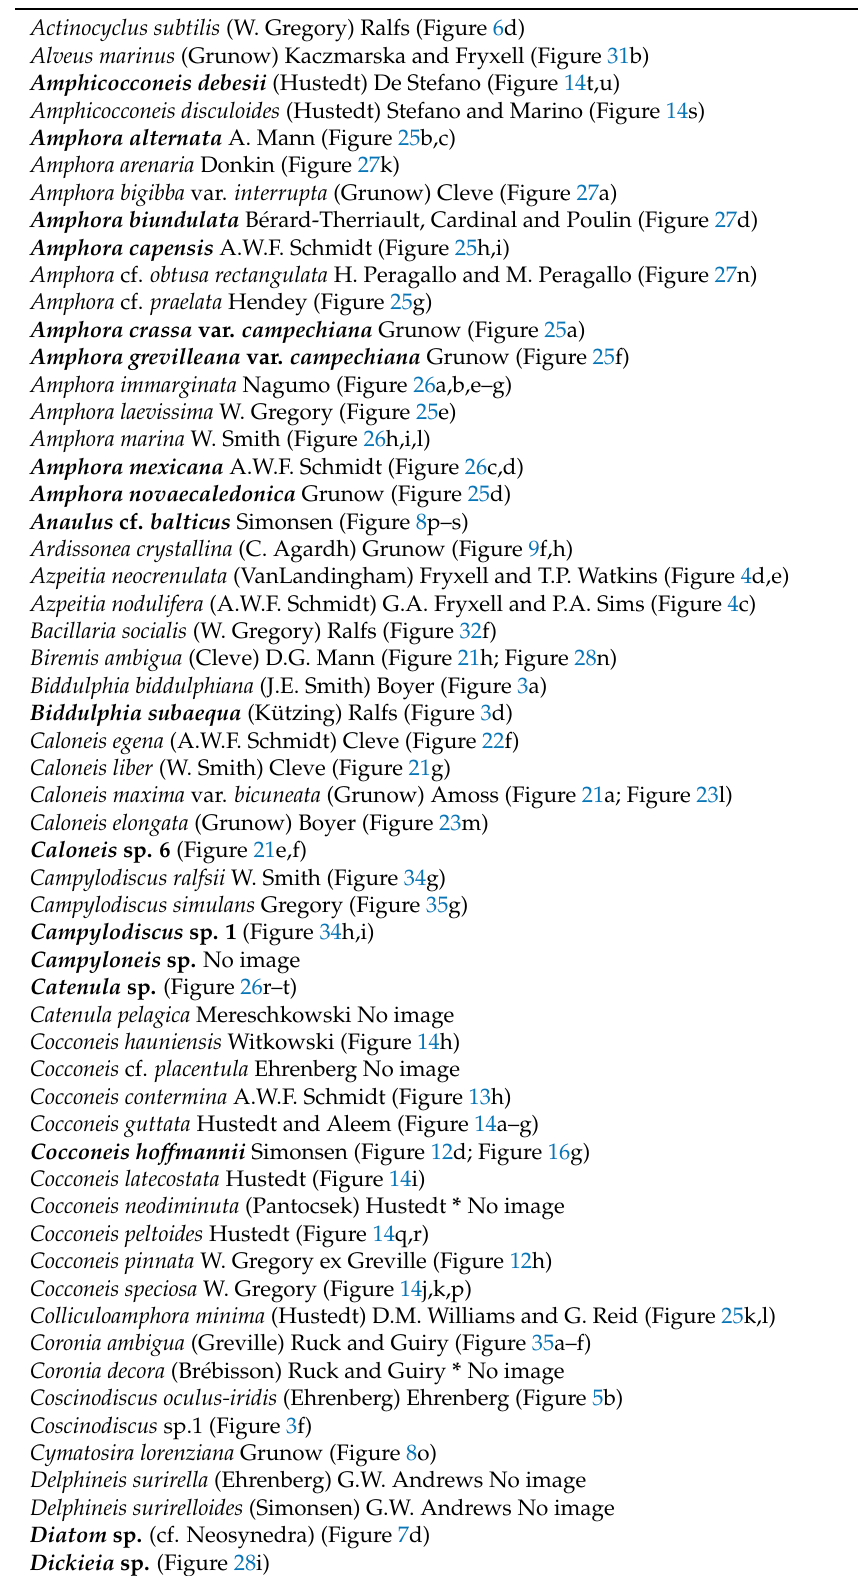
Table 1. Cont. Actinocyclus subtilis (W. Gregory) Ralfs (Figure 6d) Alveus marinus (Grunow) Kaczmarska and Fryxell (Figure 31b) Amphicocconeis debesii (Hustedt) De Stefano (Figure 14t,u) Amphicocconeis disculoides (Hustedt) Stefano and Marino (Figure 14s) Amphora alternata A. Mann (Figure 25b,c) Amphora arenaria Donkin (Figure 27k) Amphora bigibba var. interrupta (Grunow) Cleve (Figure 27a) Amphora biundulata B é rard-Therriault, Cardinal and Poulin (Figure 27d) Amphora capensis A.W.F. Schmidt (Figure 25h,i) Amphora cf. obtusa rectangulata H. Peragallo and M. Peragallo (Figure 27n) Amphora cf. praelata Hendey (Figure 25g) Amphora crassa var. campechiana Grunow (Figure 25a) Amphora grevilleana var. campechiana Grunow (Figure 25f) Amphora immarginata Nagumo (Figure 26a,b,e–g) Amphora laevissima W. Gregory (Figure 25e) Amphora marina W. Smith (Figure 26h,i,l) Amphora mexicana A.W.F. Schmidt (Figure 26c,d) Amphora novaecaledonica Grunow (Figure 25d) Anaulus cf. balticus Simonsen (Figure 8p–s) Ardissonea crystallina (C. Agardh) Grunow (Figure 9f,h) Azpeitia neocrenulata (VanLandingham) Fryxell and T.P. Watkins (Figure 4d,e) Azpeitia nodulifera (A.W.F. Schmidt) G.A. Fryxell and P.A. Sims (Figure 4c) Bacillaria socialis (W. Gregory) Ralfs (Figure 32f) Biremis ambigua (Cleve) D.G. Mann (Figure 21h; Figure 28n) Biddulphia biddulphiana (J.E. Smith) Boyer (Figure 3a) Biddulphia subaequa (Kützing) Ralfs (Figure 3d) Caloneis egena (A.W.F. Schmidt) Cleve (Figure 22f) Caloneis liber (W. Smith) Cleve (Figure 21g) Caloneis maxima var. bicuneata (Grunow) Amoss (Figure 21a; Figure 23l) Caloneis elongata (Grunow) Boyer (Figure 23m) Caloneis sp. 6 (Figure 21e,f) Campylodiscus ralfsii W. Smith (Figure 34g) Campylodiscus simulans Gregory (Figure 35g) Campylodiscus sp. 1 (Figure 34h,i) Campyloneis sp. No image Catenula sp. (Figure 26r–t) Catenula pelagica Mereschkowski No image Cocconeis hauniensis Witkowski (Figure 14h) Cocconeis cf. placentula Ehrenberg No image Cocconeis contermina A.W.F. Schmidt (Figure 13h) Cocconeis guttata Hustedt and Aleem (Figure 14a–g) Cocconeis hoffmannii Simonsen (Figure 12d; Figure 16g) Cocconeis latecostata Hustedt (Figure 14i) Cocconeis neodiminuta (Pantocsek) Hustedt * No image Cocconeis peltoides Hustedt (Figure 14q,r) Cocconeis pinnata W. Gregory ex Greville (Figure 12h) Cocconeis speciosa W. Gregory (Figure 14j,k,p) Colliculoamphora minima (Hustedt) D.M. Williams and G. Reid (Figure 25k,l) Coronia ambigua (Greville) Ruck and Guiry (Figure 35a–f) Coronia decora (Br é bisson) Ruck and Guiry * No image Coscinodiscus oculus-iridis (Ehrenberg) Ehrenberg (Figure 5b) Coscinodiscus sp.1 (Figure 3f) Cymatosira lorenziana Grunow (Figure 8o) Delphineis surirella (Ehrenberg) G.W. Andrews No image Delphineis surirelloides (Simonsen) G.W. Andrews No image Diatom sp. (cf. Neosynedra) (Figure 7d) Dickieia sp. (Figure 28i) Diploneis bombus Ehrenberg (Figure